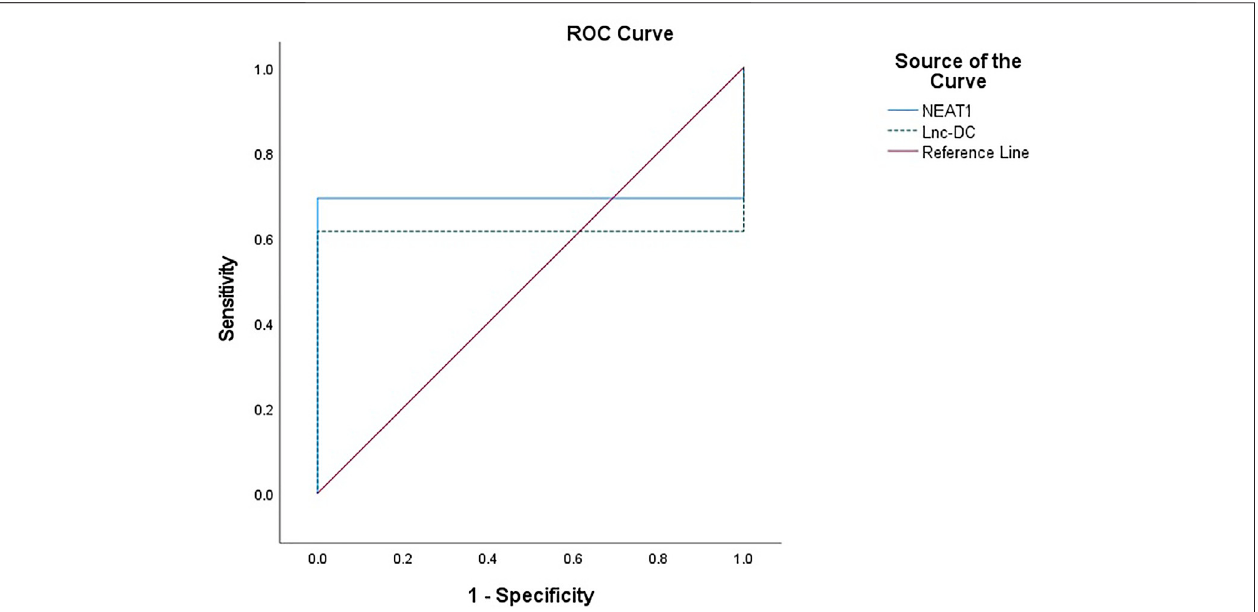
FIGURE 2 | ROC curve to predict the diagnostic performance of NEAT1 and lnc-DC found in serum for differentiating BD patients from controls. ROC curves showed that the expression of NEAT1 and lnc-DC in serum could be used as predictors of BD. NEAT1 had an area under the curve (AUC) of 0.692 (95% CI: 0.591 – 0.794, p (cid:1) 0.001), and lnc-DC had an AUC of 0.615 (95% CI: 0.508 – 0.723, p (cid:1)